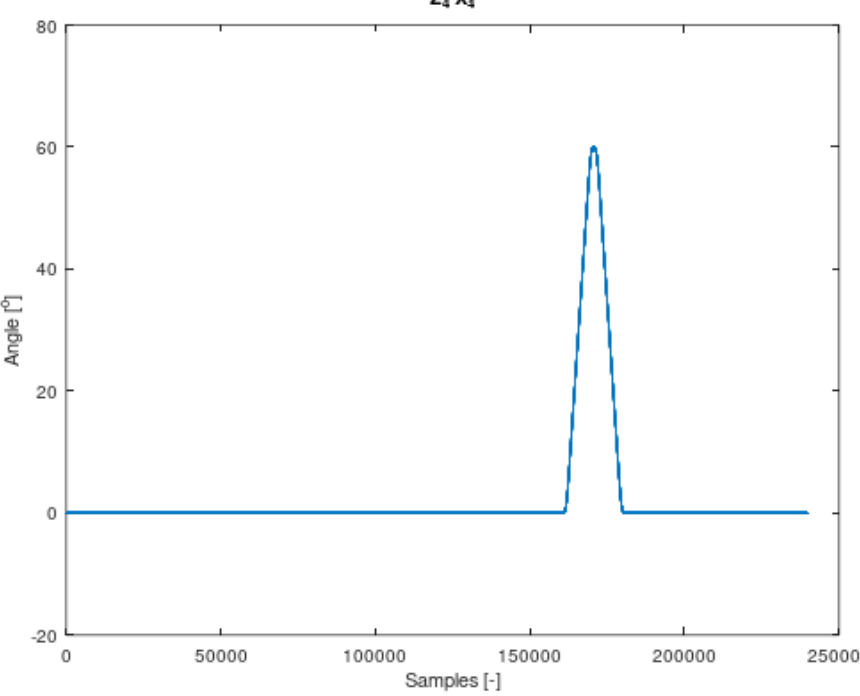
Figure 6. The angle set on the robot axis to which the coordinate system is assigned z 3 x 3 in Figure 3. Data from FANUC robot encoders collected using the apparatus.